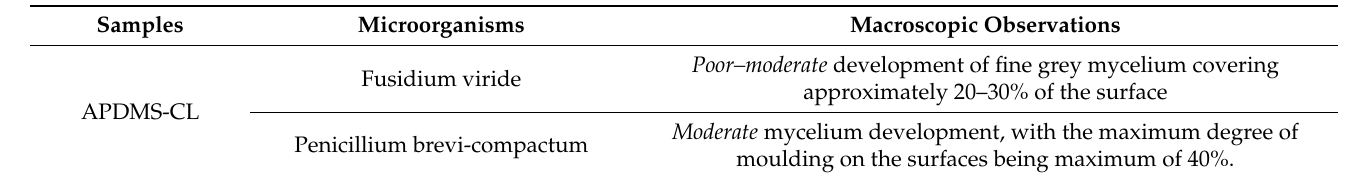
Figure 11. Macroscopic and microscopic images of the APDMS-CL sample on the surface of which